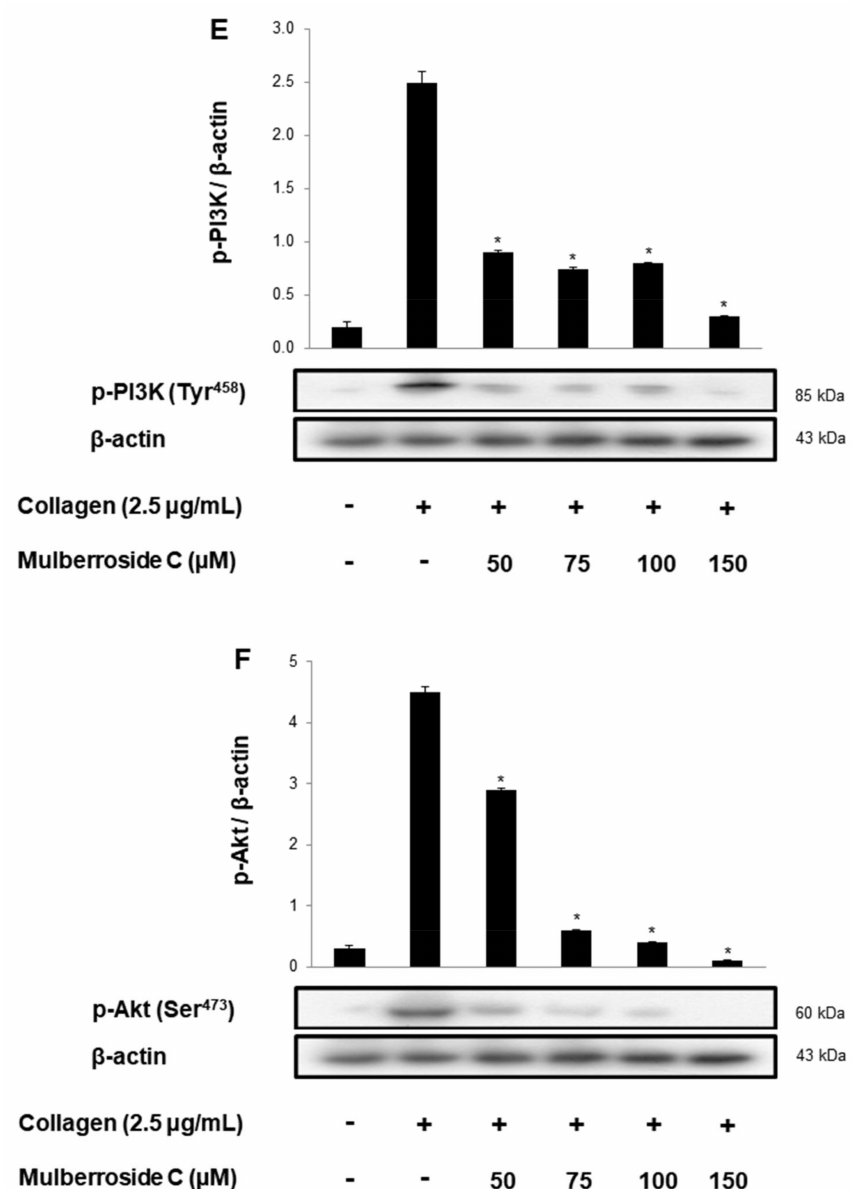
Figure 6. Effects of mulberroside C on fibrinogen binding to α IIb/ β 3, VASP, and PI3K/Akt phos- phorylation ( A ) The flow cytometry histograms on fibrinogen binding; ( B ) Effects of mulberroside C on collagen-induced fibrinogen binding (%); ( C ) Effect of mulberroside C on collagen-induced VASP (Ser 157 ) phosphorylation; ( D ) Effect of mulberroside C on collagen-induced VASP (Ser 239 ) phosphorylation; ( E ) Effect of mulberroside C on collagen-induced PI3K (Tyr 458 ) phosphorylation; ( F ) Effect of mulberroside C on collagen-induced Akt (Ser 473 ) phosphorylation. Measurement of fibrinogen binding, fibronectin adhesion, and Western blot was carried out as described in Section 2. The data are expressed as the mean ± standard deviation ( n = 4). * p < 0.05, ** p < 0.01 versus the collagen-stimulated human